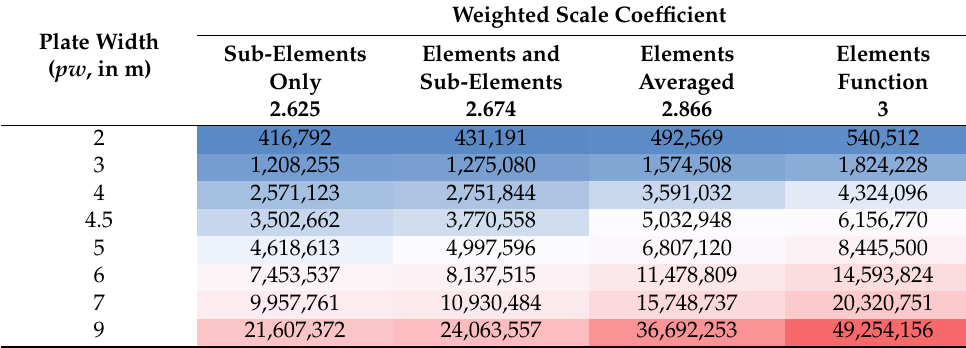
Table 12. Wavepiston WEC cost (in € ) using the Similitude method over the string length. The darkest red cell is the highest value of the entire table, and the darkest blue reflects the lowest one. Number of Plates Weighted Scale Coefficient Plate-Location ( Np , in –) Configuration ( plc , Sub-Elements Only in m)